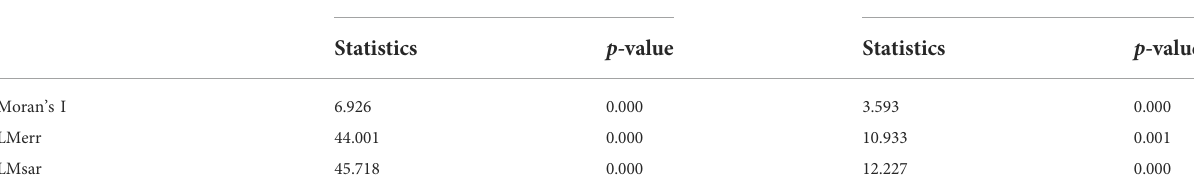
TABLE 6 Spatial correlation test.